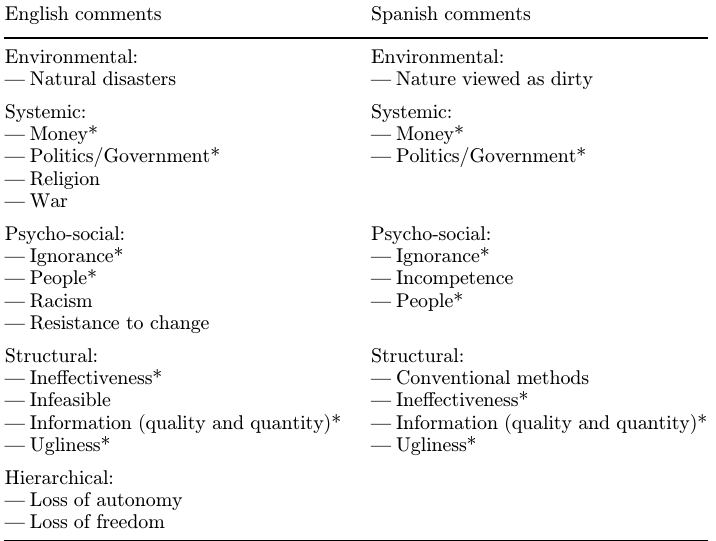
Table 2. Summary of barriers for sustainable design